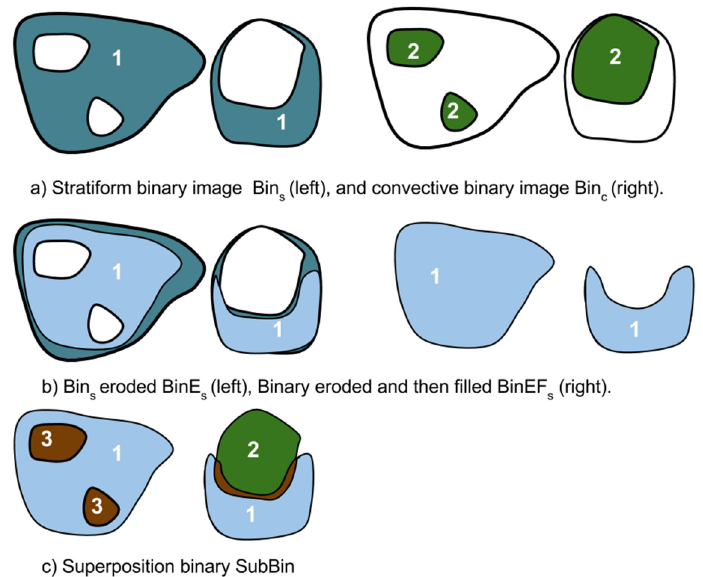
Figure-2. A schematic representation of the proposed methodology to separate enveloped and un- enveloped systems. ( a ) Binaries of convective ( 𝐵𝑖𝑛 (cid:3030) ) and stratiform ( 𝐵𝑖𝑛 (cid:3046) ) systems are separated, 𝐵𝑖𝑛 (cid:3030) takes values of 0 and 2, 𝐵𝑖𝑛 (cid:3046) takes values of 0 and 1. ( b ) 𝐵𝑖𝑛 (cid:3046) is eroded and 𝐵𝑖𝑛𝐸 (cid:3046) is ob- tained, then 𝐵𝑖𝑛𝐸𝐹 (cid:3046) is obtained by filling holes in the binary. ( c ) 𝑆𝑢𝑏𝐵𝑖𝑛 is computed as the sum of 𝐵𝑖𝑛 (cid:3030) and 𝐵𝑖𝑛𝐸𝐹 (cid:3046) . 𝑆𝑢𝑏𝐵𝑖𝑛 values equal to 2 correspond to unenveloped convective systems, and values of 3 correspond to enveloped systems.